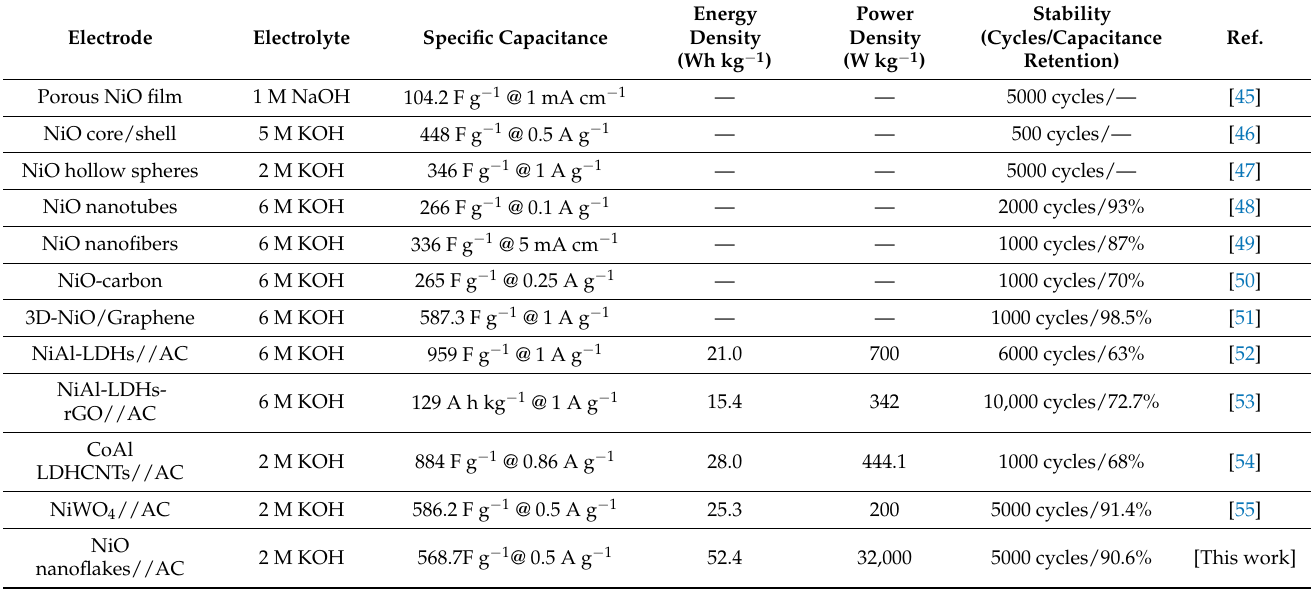
Table 1. Comparison of the electrochemical performances of the NiO electrode and those of related metal oxide electrode